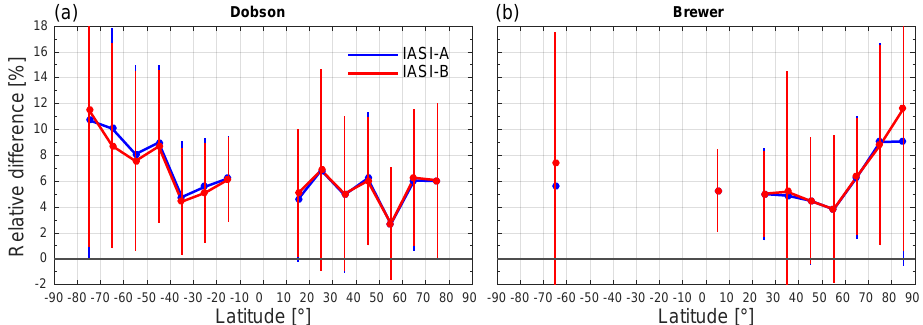
Figure 10. Latitudinal variability of the relative differences (in percent) between IASI-A (blue) and IASI-B (red) against co-located Dob- son (a) and Brewer (b) given in bins of 10 ◦ . For the period March 2013 onwards, only the common co-locations between the two satellites are shown. The associated standard deviation of the relative differences is also